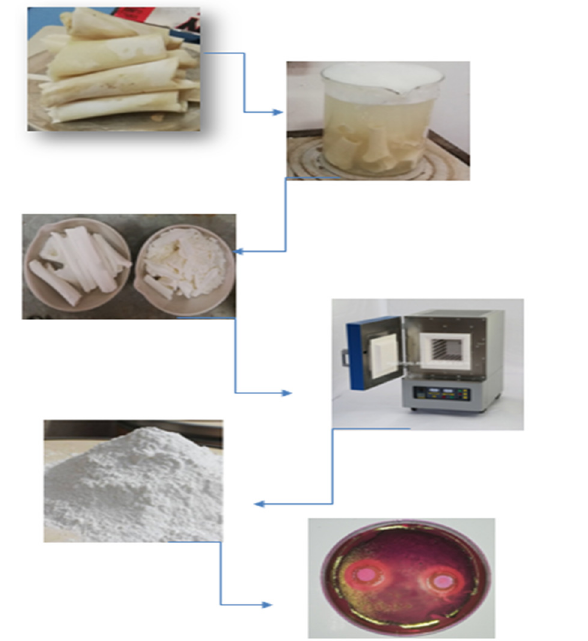
Fig. 2: shows the pictorial representation of the complete process